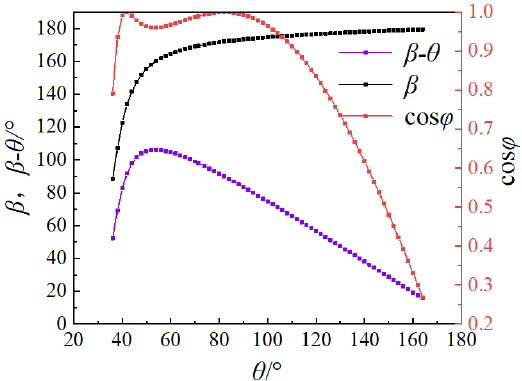
Figure 6. The power factor curve.